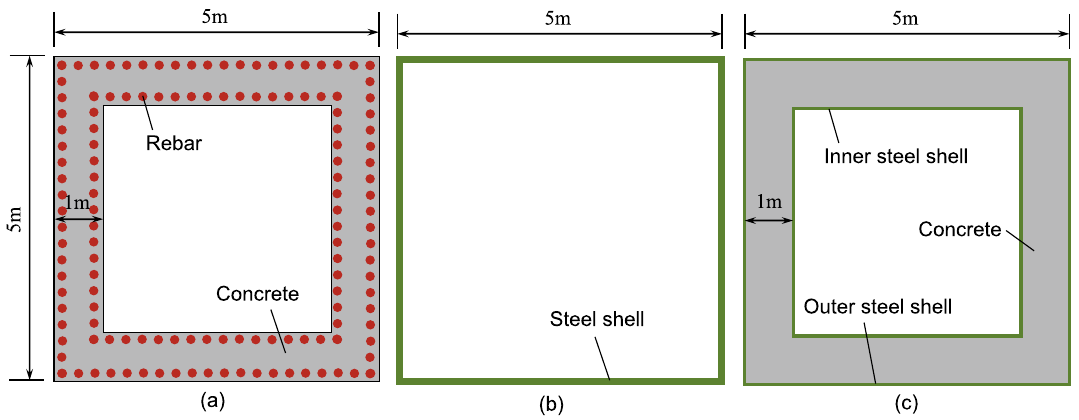
Figure 6. Three types of cross-sectional diagrams: ( a ) concrete section; ( b ) steel section; ( c ) steel-concrete-steel sandwich composite section.